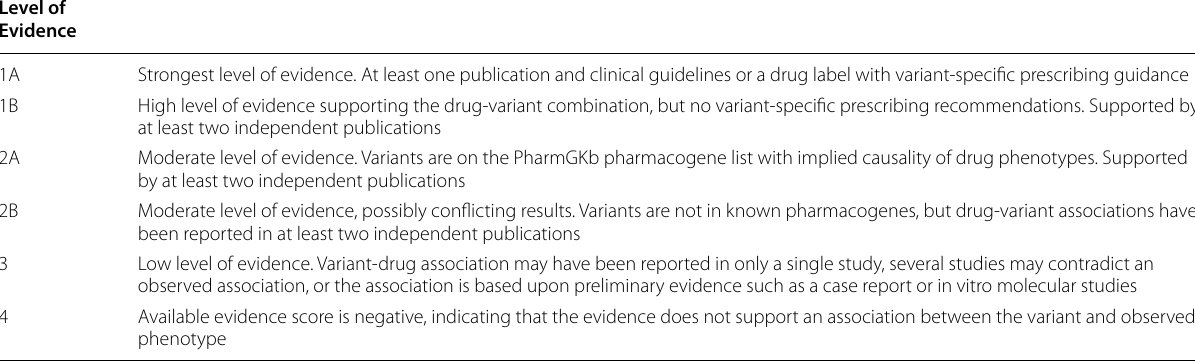
Table 2 PharmGKb clinical annotation levels. Descriptions are adapted from the PharmGKb website available at: https:// www. pharm gkb. org/ page/ clinA nnLev els PharmGKb Level